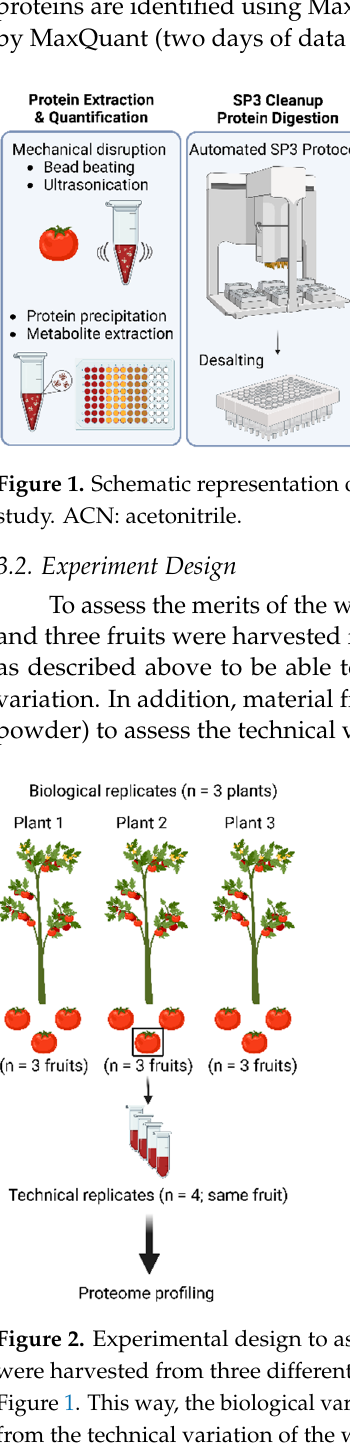
( c ) Figure 3. Summary of peptide and protein identifications of technical workflow replicates ( n = 4). ( a ) Identification of proteins when searching the Uniprot or TAG 4.0 sequence databases and either including or excluding re ‐ scoring of MaxQuant results using the artificial intelligence Prosit. Black